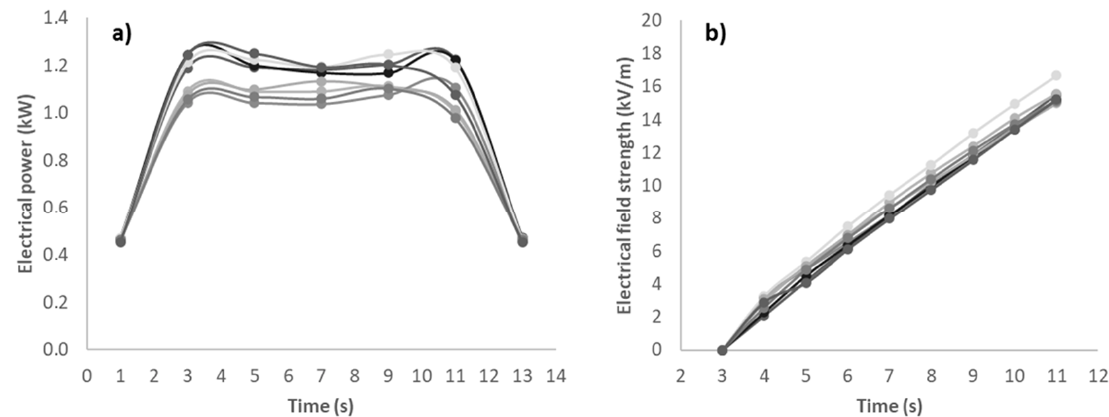
Figure 7. Machine power consumption ( a ) and development of cumulated electrical field strength (( b ), plateau phase only) during cutting of an 800 mm long and 10 mm deep grooves into 8 beech wood panels using a w/o coated 60 teeth circular sawing blade (1600 rpm, f z = 0.063 mm), n = 8.